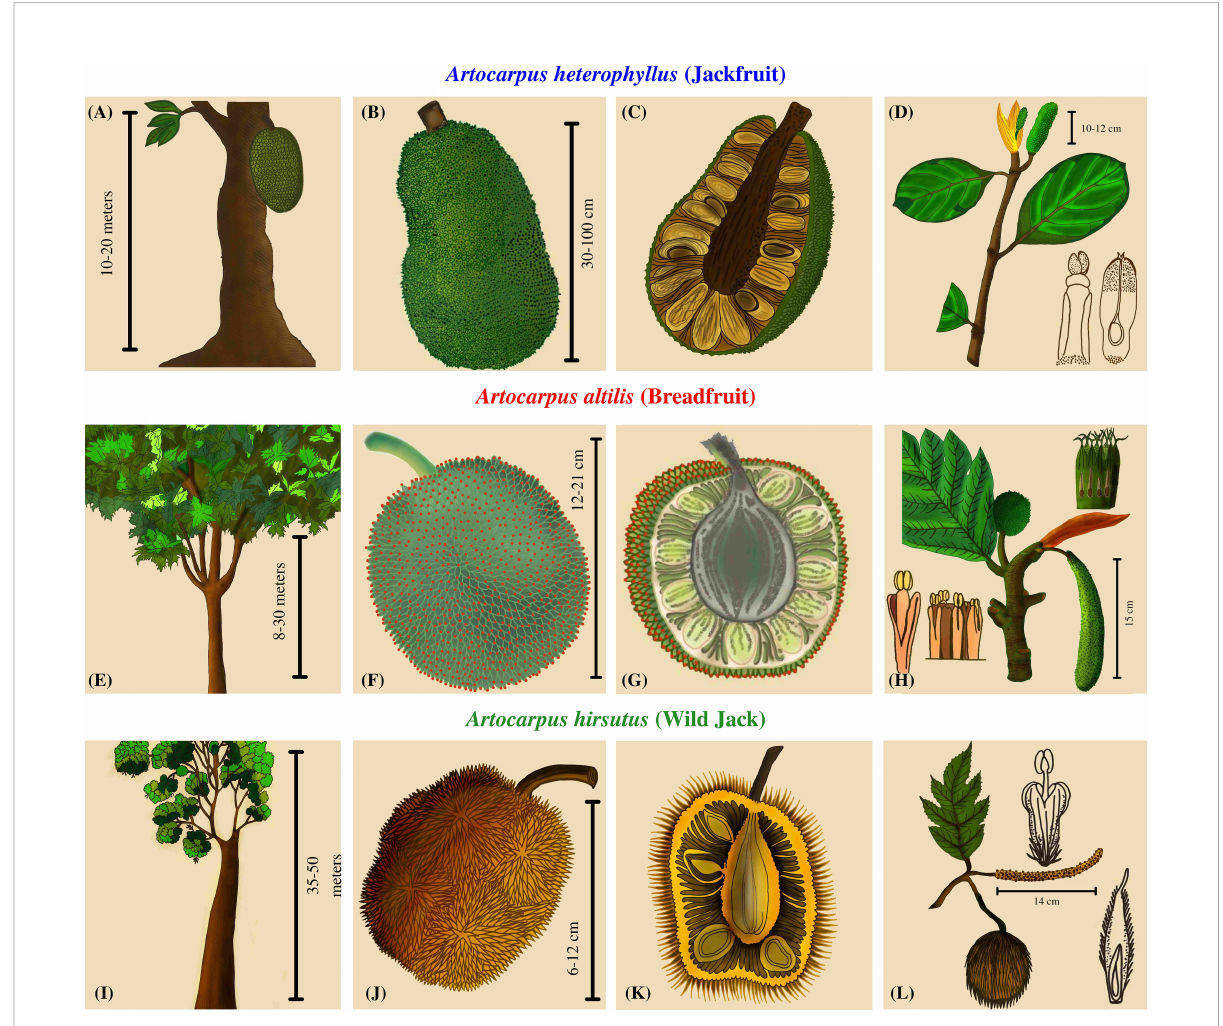
FIGURE 1 Plant morphology and comparative phenotypic characters of three Artocarpus species. (A, E, I) The fi rst column depicts the overall structure of the trees. (B, F, J) The second column contains drawings of the fruit describing the color, shape, and size. (C, G, K) The third column has a cross- sectional view of the fruits depicting the number and arrangement of seeds. (D, H, L) The fourth column has drawings of the in fl